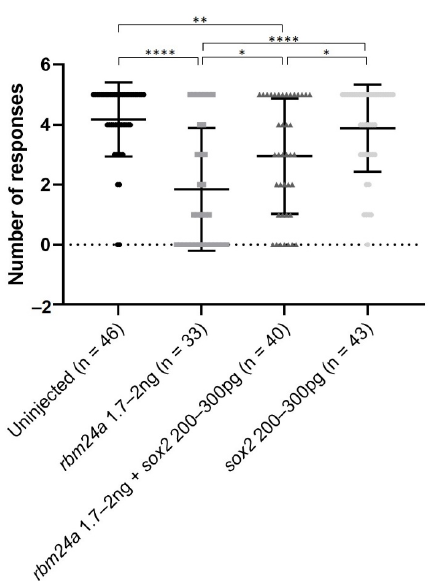
Figure 6. Injection of sox2 RNA can partially restore visual function by VIZN to rbm24a knockdown embryos. VIZN was performed on uninjected, rbm24a knockdown, rbm24a knockdown with sox2 RNA, and sox2 RNA larvae. Knockdown of rbm24a statistically significantly inhibits visual function when compared to uninjected. Addition of sox2 RNA to rbm24a knockdown statistically significantly improves visual function when compared to rbm24a knockdown, but not to the same level as uninjected. Injection of sox2 RNA alone does not statistically significantly alter visual function from uninjected. Mann–Whitney * p < 0.05, ** p < 0.01, **** p < 0.0001. Nonsignificant interactions not shown.